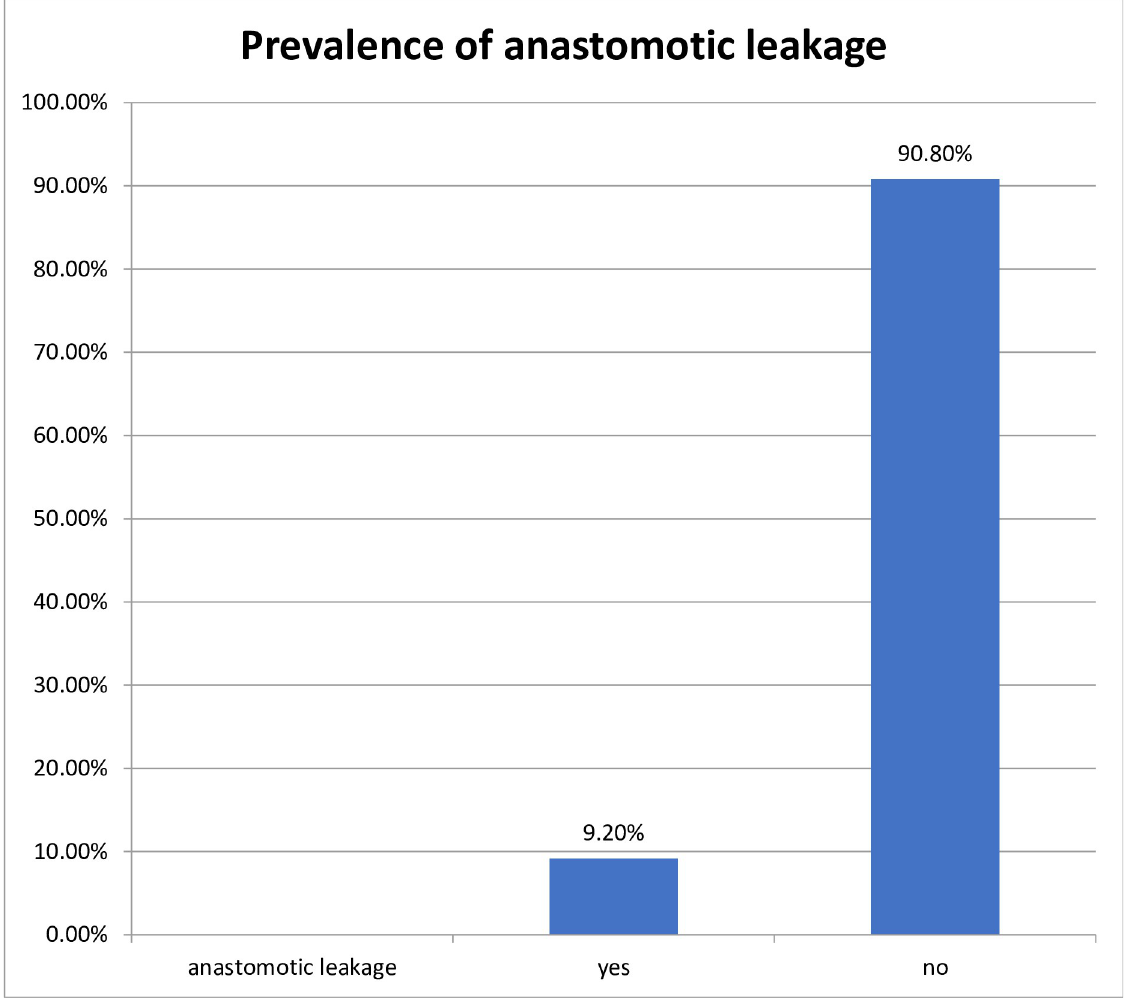
Fig 3. Magnitude of clinical anastomosis leakage among patients who had intestinal anastomosis in Northwest Amhara regional State referral Hospitals, from February 2017 to February 2020 (n =